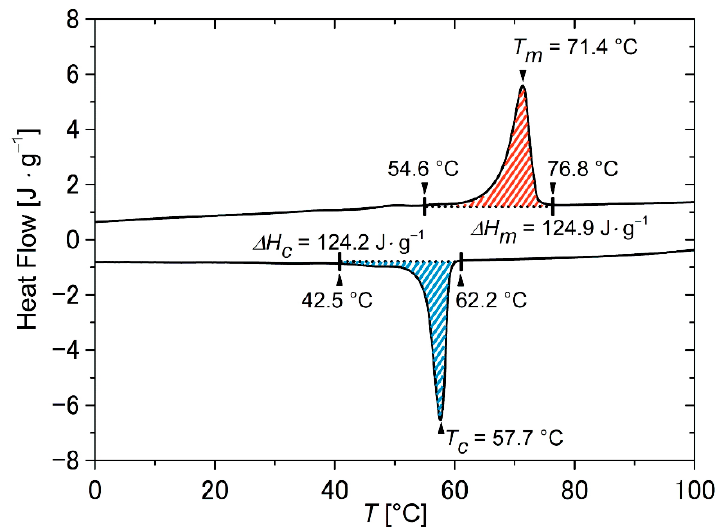
Figure 2. Differential scanning calorimetry (DSC) thermogram of poly(1,10-decylene adipate) diol showing the second heating and cooling with temperature rates of 10 °C·min –1 . The enthalpies of melting Δ H m (red dashed area) and crystallization Δ H c (blue dashed area) are included.